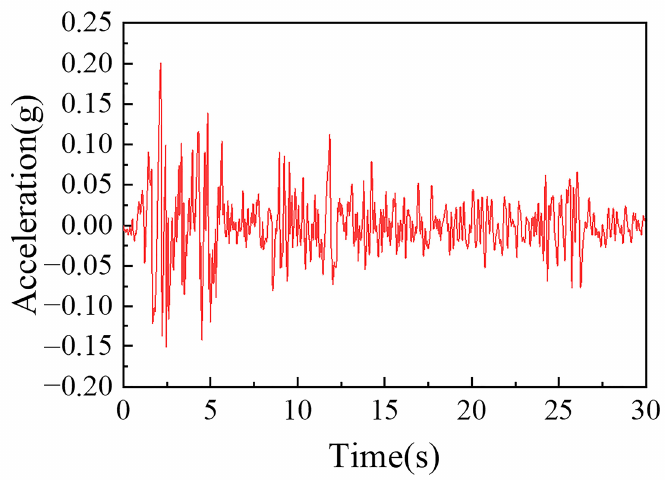
Figure 4. M-C and D-P in slant plane.